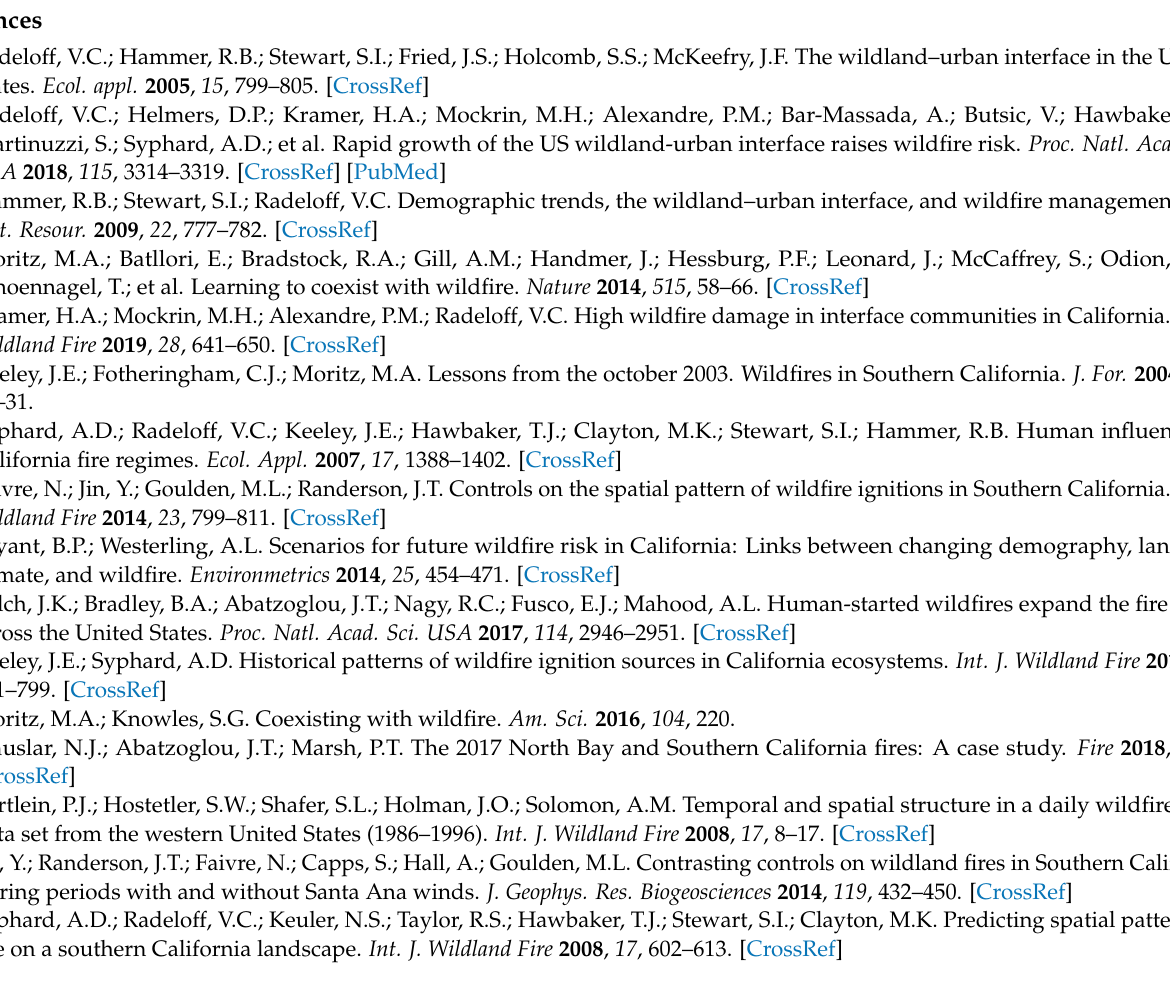
Figure A3. Ignition points from the three ignition modeling methods (colored dots) and previous ignition locations (black stars) overlaid on roads and trails (black lines).